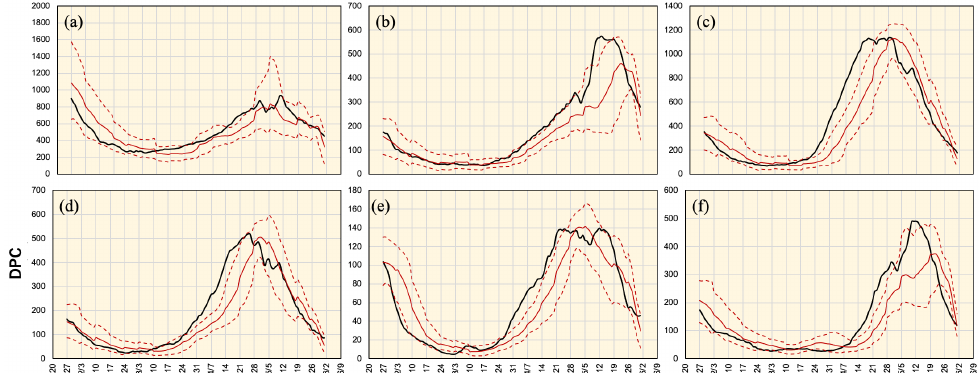
Figure 6. Actual (black) and average estimated (red) DPC in ( a ) Tokyo, ( b ) Aichi, ( c ) Osaka, ( d ) Hyogo, ( e ) Kyoto, and ( f ) Fukuoka within all 15 time periods. Dotted lines represent average maximum and minimum